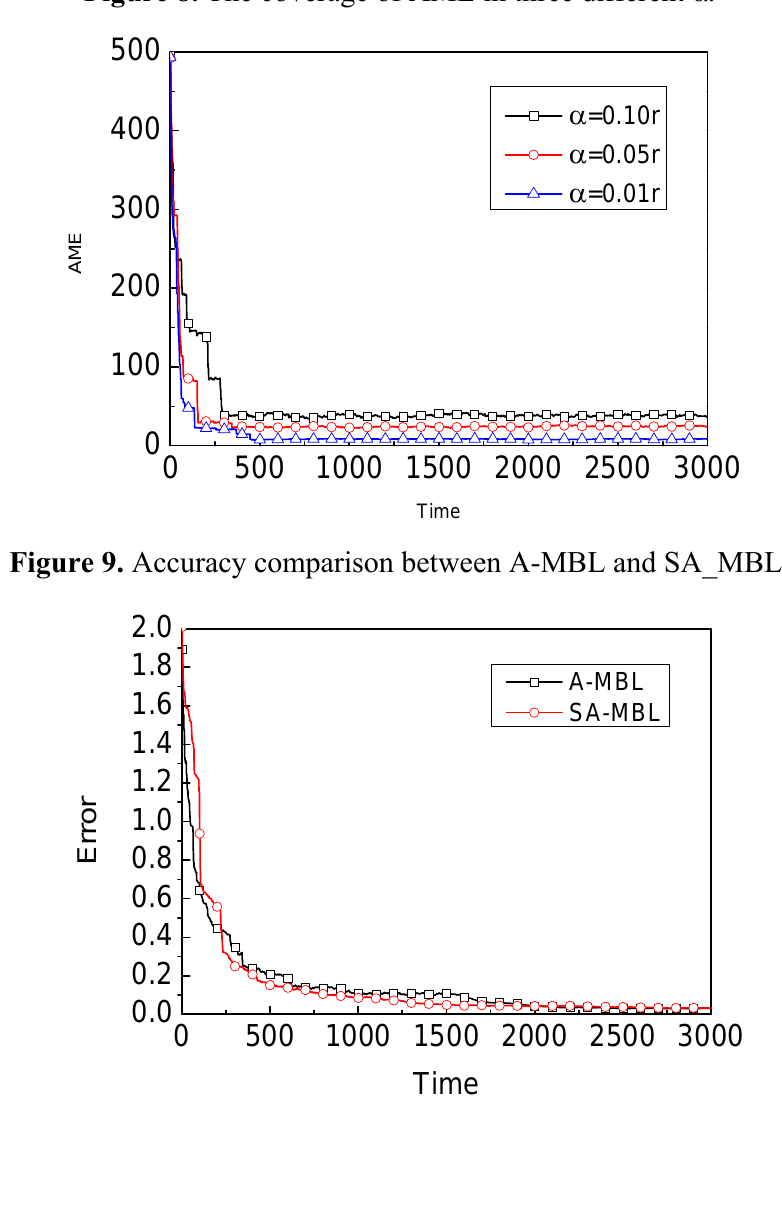
Figure 8. The coverage of AME in three different α .